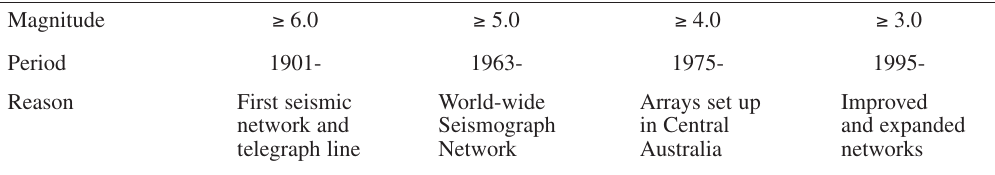
Table I. Magnitude completeness intervals in Australia.